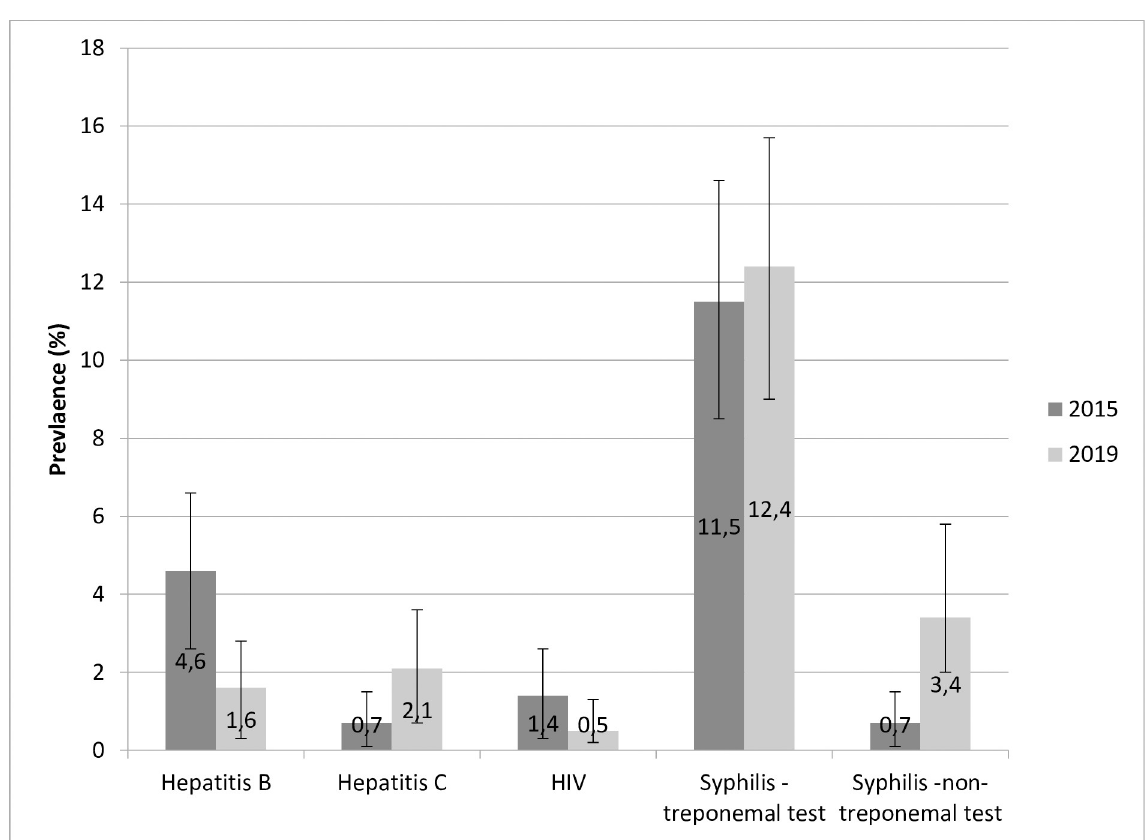
Fig 2. Prevalence of HBC, HCV, HIV, and syphilis among illegal gold miners working in French Guiana in 2015 and 2019.